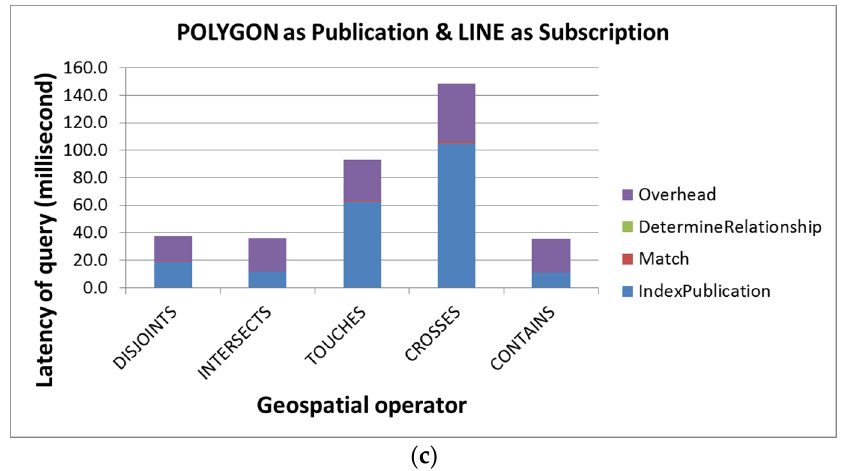
Figure 8. The end-to-end query performance for line as subscription and ( a ) point; ( b ) line; and ( c ) polygon geometry as publication.